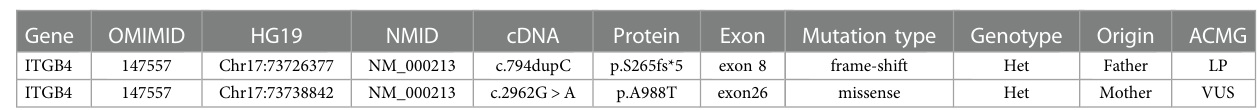
TABLE 1 Genotype with candidate gene abnormalities in this